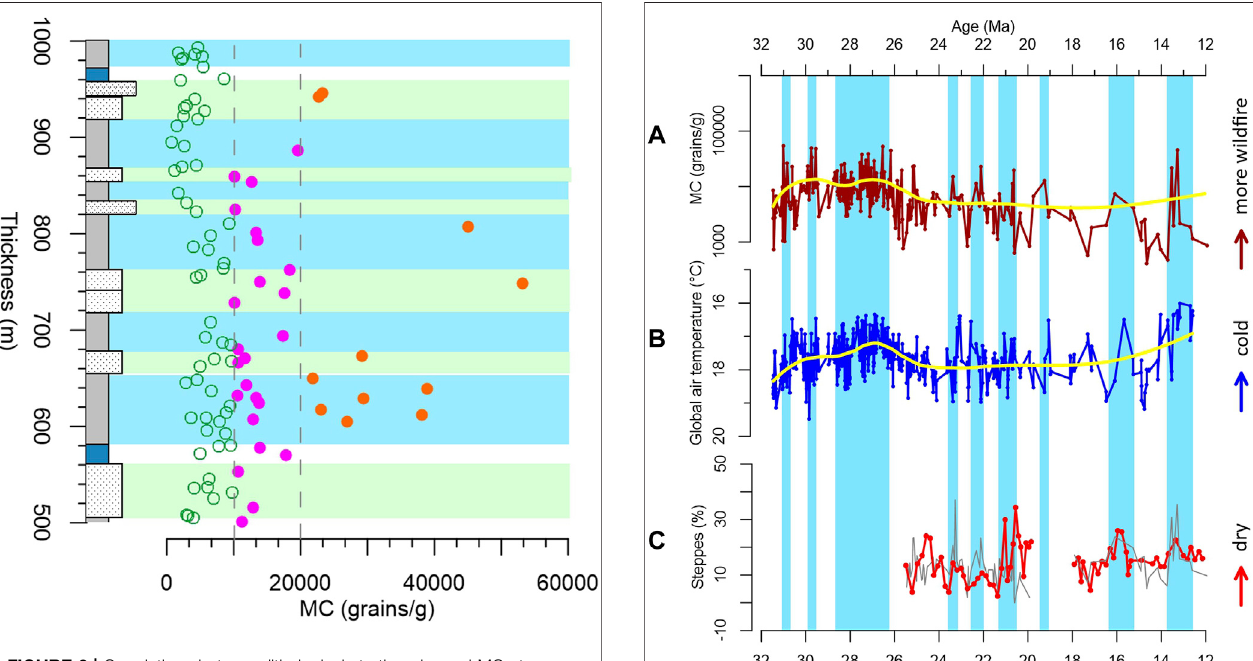
Frontiers in Earth Science |